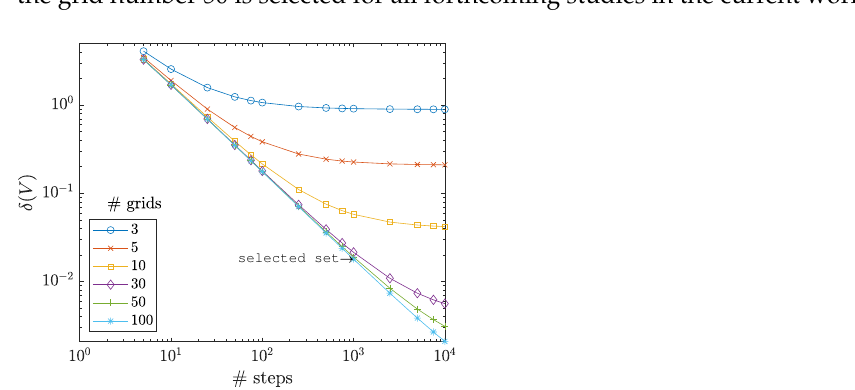
Figure 3. The percentage volume change error as a function of numbers of simulation steps and grids. With an arbitrarily small threshold of δ ( V ) max = 0.02%, the features for the forthcoming tests of the current study are